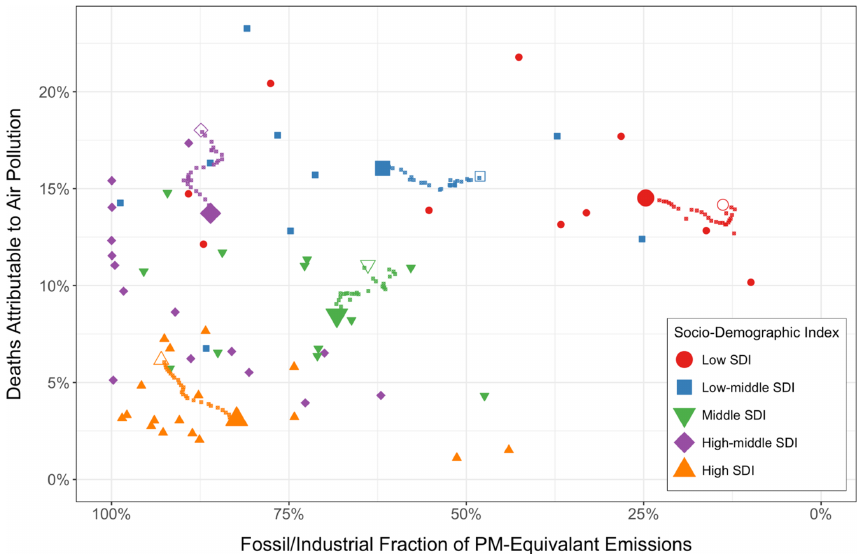
Figure 2. Illustrative figure showing the relationship between emissions sources and the fraction of “all cause” deaths attributable to annual air pollution (e.g., outdoor and indoor PM 2 . 5 as well as O 3 ) exposure over time and by socio-demographic category. The fraction of all deaths in 2019 attributable to annual air pollution exposure ( y axis) by major socio-demographic index (SDI) groups (large symbols) from the GBD project (GBD 2019 Risk Factor Collaborators, 2020) plotted against the fraction of equivalent particulate matter (PM) emissions from fossil and industrial sources (van Marle et al., 2017; O’Rourke et al., 2021; see Appendix for definitions). The largest countries within each SDI group are shown as small individual symbols. The trajectory over 1990 (open symbols) to 2019 (large filled symbols) for each country SDI group is shown by the smaller trailing symbols. Countries in the lower left position have the lowest mortality from air pollution, with PM largely from fossil and industrial sources. Countries in the upper right have a higher disease burden from air pollution and PM largely from non-fossil sources such as forest and grassland fires as well as household use of solid